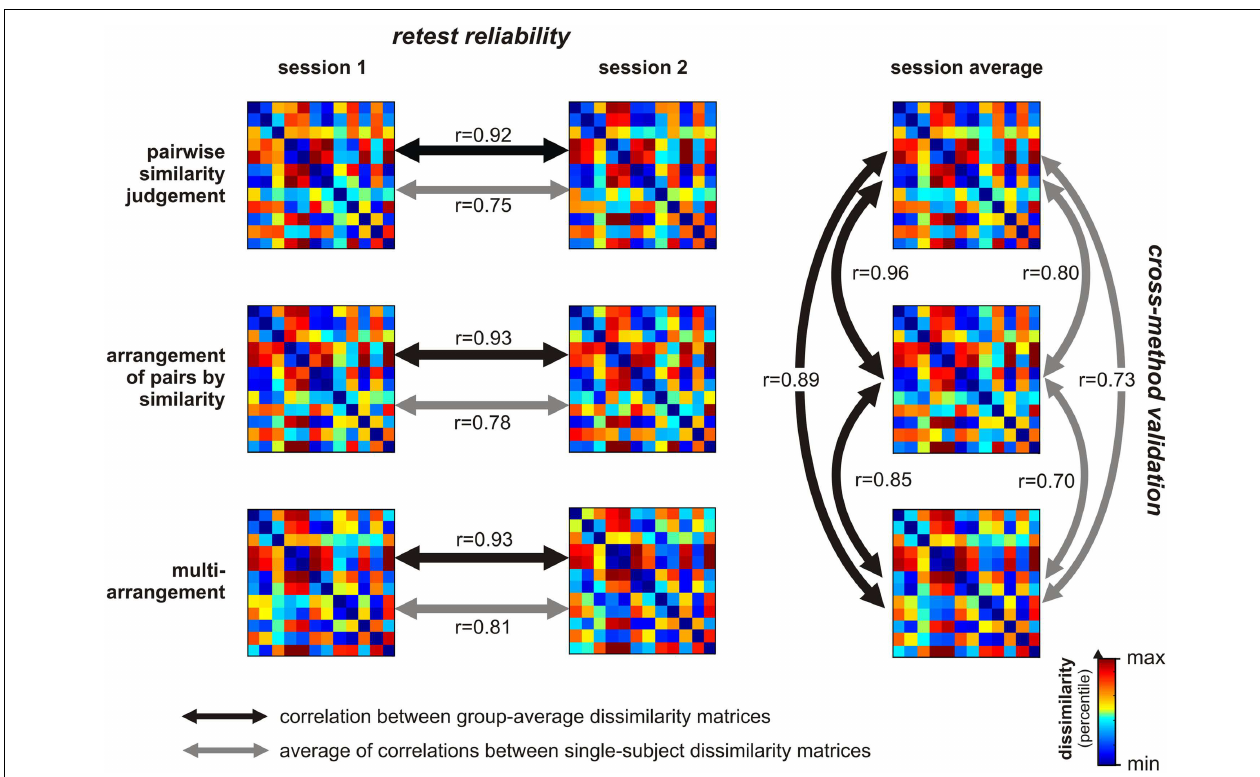
way the data were combined across subjects: we either averaged the single-subject data at the level of the RDMs (black double arrows) or at the level of the correlation coefficients (gray double arrows). Each arrow’s line thickness is proportional to the Spearman correlation coefficient it represents. Condition-label randomization tests on the black-arrow correlation coefficients showed that they are all significantly positive ( p < 0.0001 for each comparison).These findings indicate that the test-retest reliability of all three methods is high, and suggest that multi-arrangement is a valid method for measuring perceived